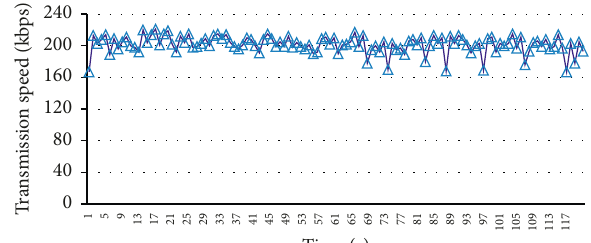
Figure 7: Throughput of the proposed scheme.